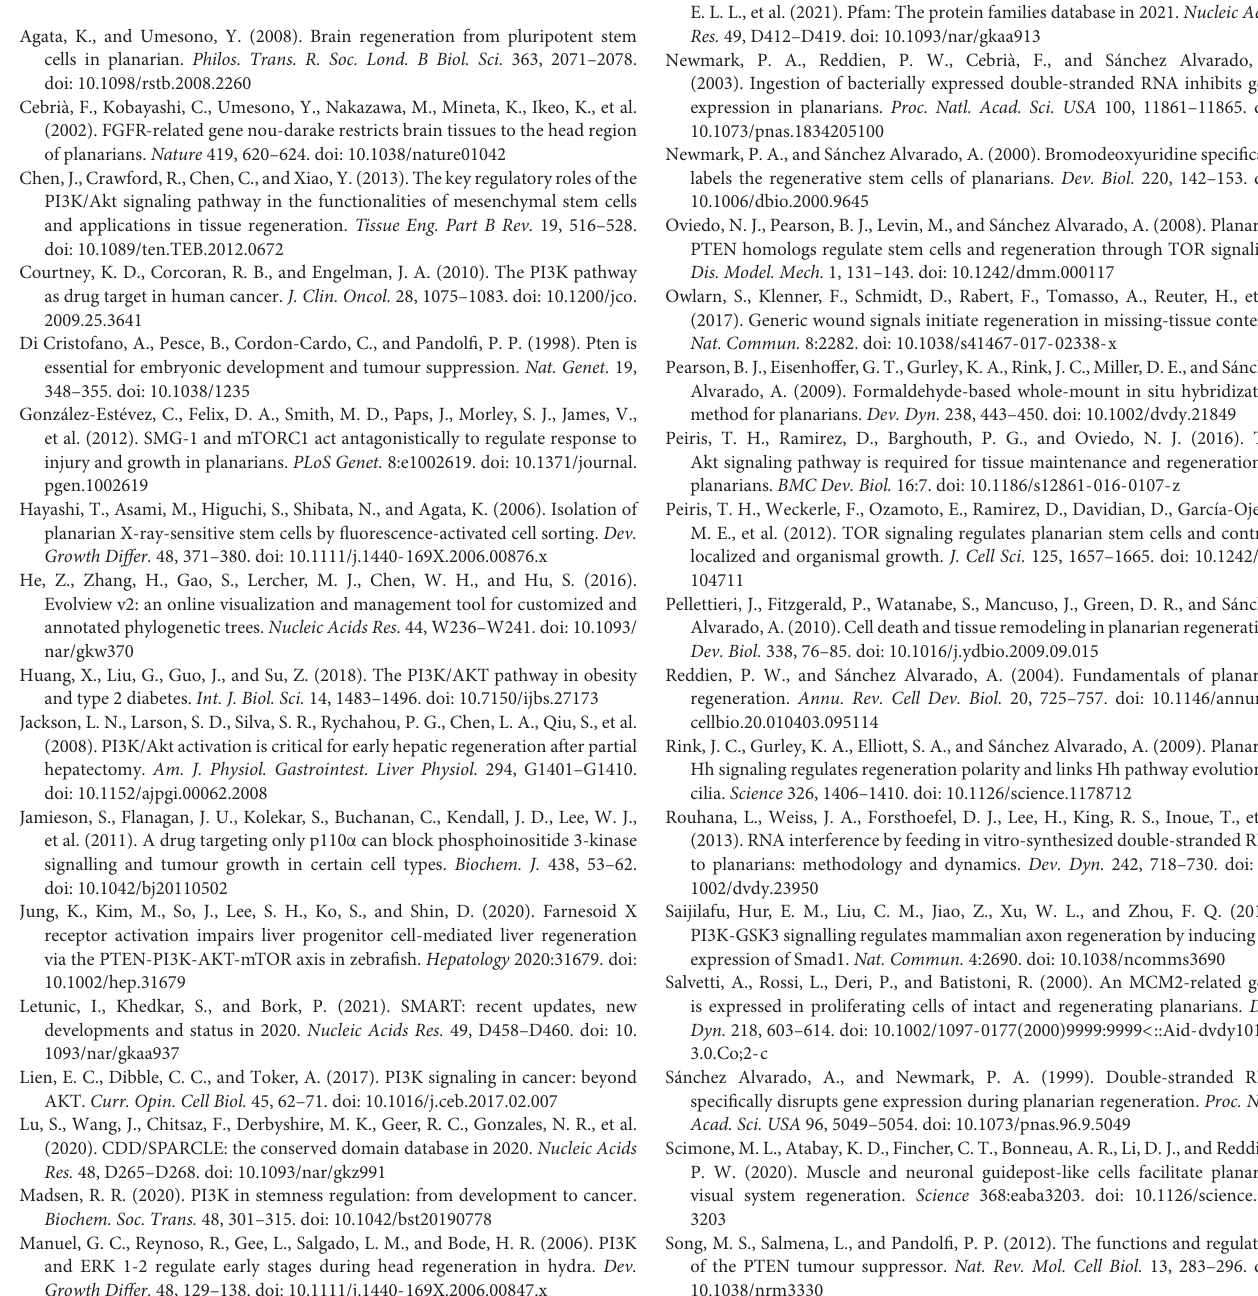
fragments. The expression level of Djmcm2 at 0 hpa was set to one. ∗∗ P < 0.01 and ∗∗∗ P < 0.001, by the Student’s t -test. Supplementary Figure 6 | Effect of Djpi3k RNAi knockdown on apoptotic cell death during planarian regeneration. (A) Immunostaining of TUNEL-positive nuclei of trunk fragments at 0 h, 6 h, 1 days, and 3 days post amputation. Scale bar = 100 µ m. (B) Quantification of the average number of TUNEL-positive cells/mm 2 in the whole trunk fragments (left panel) or at the amputation sites (right). ∗ P < 0.05, ∗∗ P < 0.01, ∗∗∗ P < 0.001, and ns, not significant, by the Student’s t -test. (C) Relative expression levels of Djbax gene in regenerating head